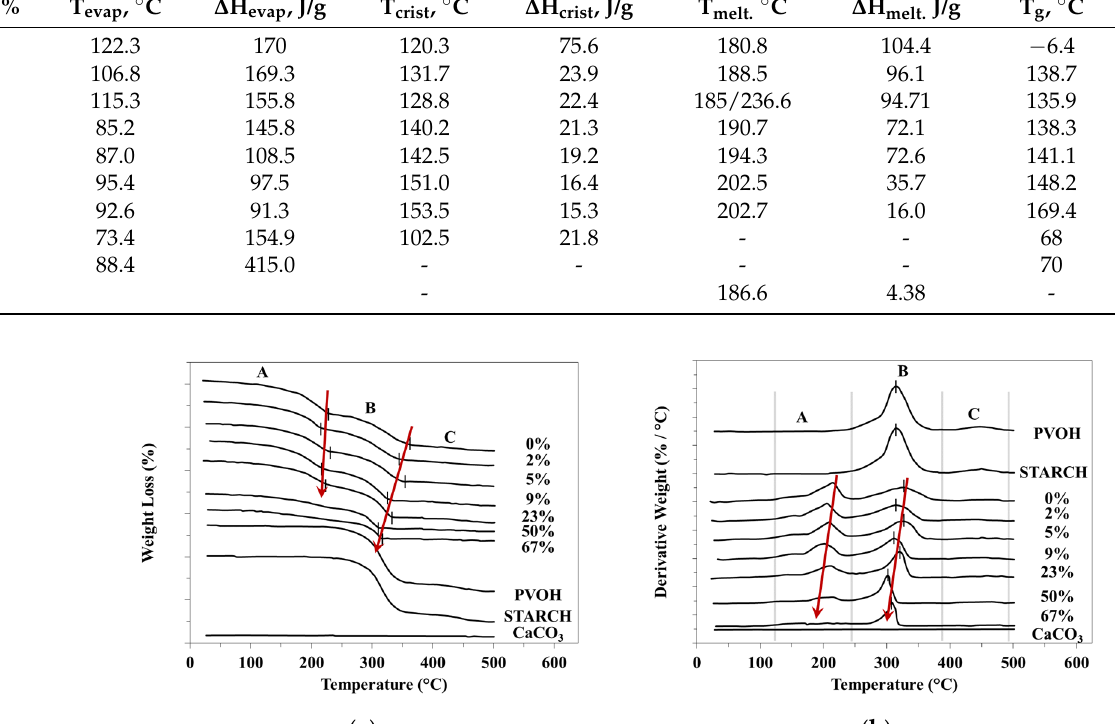
Figure 2. Degradation behaviour of ternary starch-based blends with different CaCO 3 amount: ( a )-TGA curves; ( b ) DTA curves. Table 5. Dependence of the thermo–oxidative degradability of the starch–PVOH blends on the CaCO 3